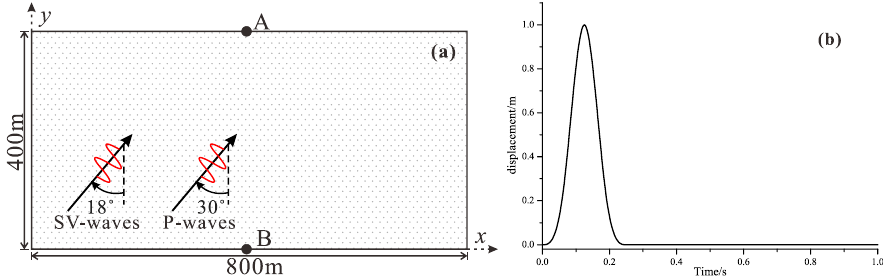
Figure 6. Numerical model and incident waves of test example 1: ( a ) finite element model and ( b ) displacement time history of incident waves.